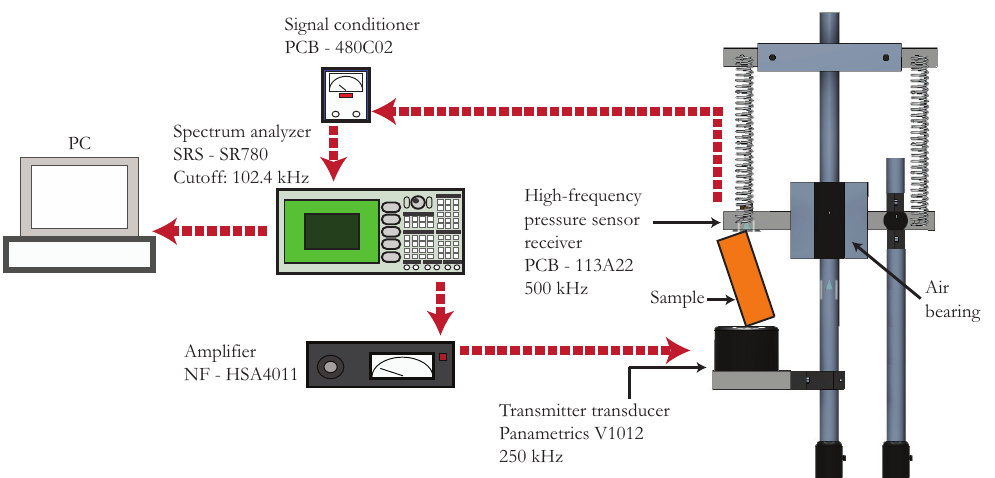
Figure 2. Schematic illustration of the experimental setup used for both RUS and NRUS. The sample is positioned between a contact ultrasonic transducer and a high frequency response pressure sensor. The set of springs and the air bearing ensure that the contact force applied to the sample is very small, which enables to compare the measured resonant frequencies with those of a free-stress parallelepiped. For resonances below 102.4 kHz a spectrum analyzer is used for the frequency sweep. Above this frequency limit, this apparatus is replaced by a National Instruments digital-to-analog acquisition card, model PCI-6251.